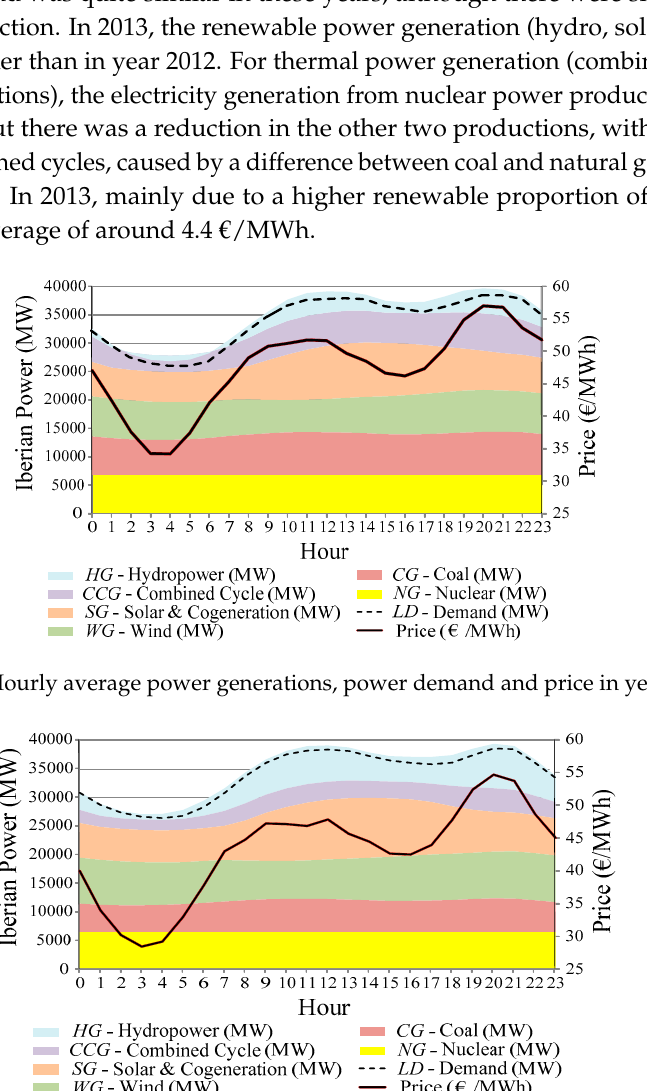
Table 2. Descriptive statistics of price data.